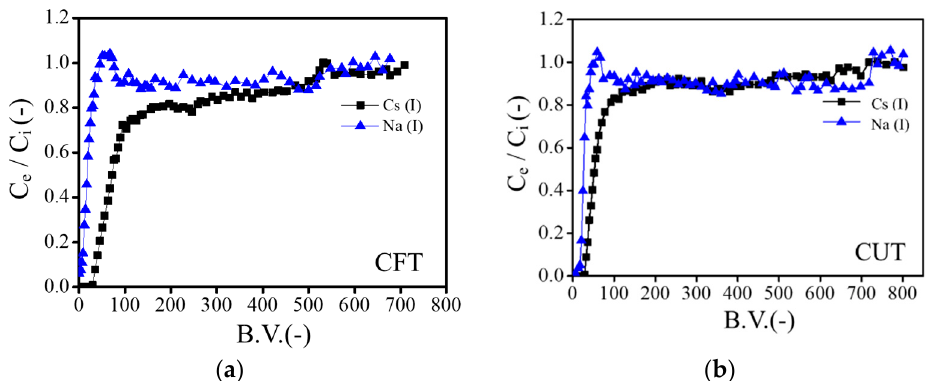
Figure 8. Breakthrough profiles of Cs + and Na + ions upon passing the column packed with ( a ) crosslinked fresh tea leaves (CFT) adsorbents and ( b ) crosslinked used tea leaves (CUT) adsorbents, pH e = 7.7 (CFT) and 7.4 (CUT), weight of adsorbents = 0.15 g (0.515 cm 3 ), [Cs + ] i = 1.84 mM (CFT), 1.80 mM (CUT), [Na + ] i = 2.68 mM (CFT), 2.39 mM (CUT), flow rate = 5.52 cm 3 h − 1 (CFT) and 5.85 cm 3 h − 1 (CUT). Table 4. Separation and removal of Cs + from the mixture of Na + ions.